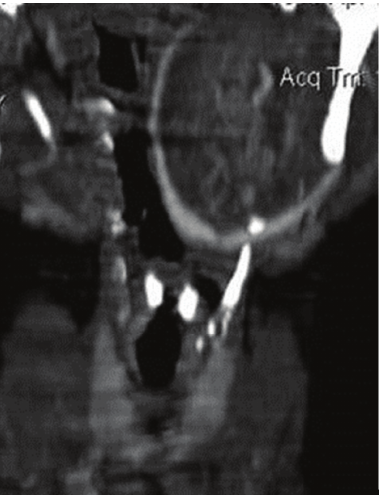
Figure 10: Coronal reconstructed CT image demonstrates splaying of carotid bifurcation by the